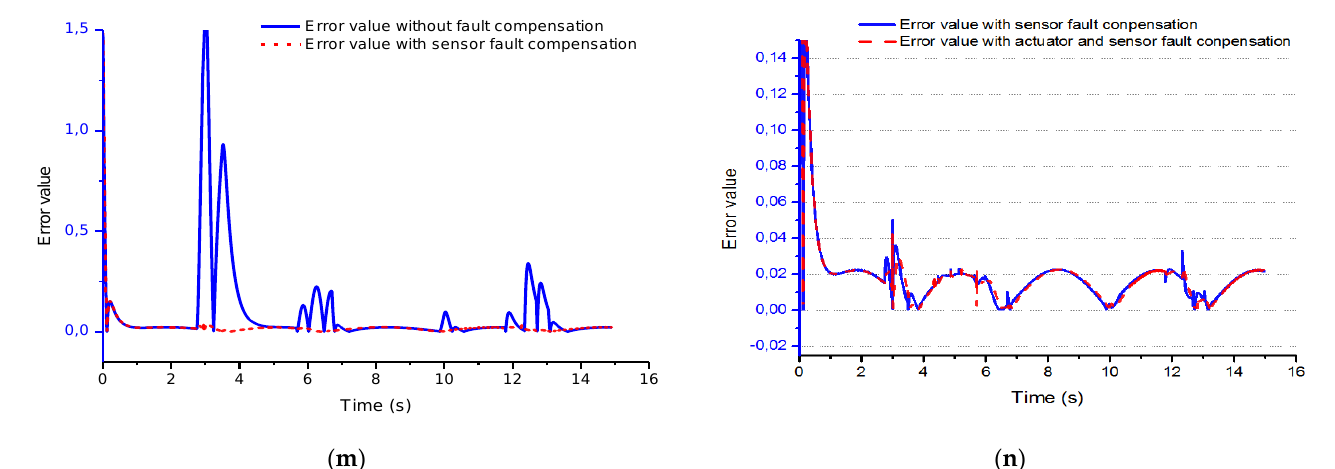
Figure 6. Simulation results of EHA system under the impact of the actuator fault, the position, and velocity sensor fault. ( a ) Position response for the case without compensation of ( f a , f P , f v ) faults. ( b ) Actuator fault estimation for the case without compensation of ( f a , f P , f v ) faults. ( c ) Position sensor fault estimation for the case without compensation of ( f a , f ) faults. ( d ) Velocity fault estimation for the case without compensation of ( f a , f ) faults. ( e ) Control error for the case without ( f a , f P , f v ) fault compensation. ( f ) Control error evaluation for the case without ( f a , f P , f v ) fault compensation. ( g ) Control error for the case with ( f P , f v ) fault compensation. ( h ) The obtained error evaluation for the case with ( f P , f v ) fault compensation. ( i ) Position response for the case ( f a , f P , f v ) fault compensation. ( j ) Actuator fault estimation for the case ( f a , f P , f v ) fault compensation. ( k ) Position fault estimation for the case ( f a , f P , f v ) fault compensation. ( l ) Velocity fault estimation for the case ( f a , f P , f v ) fault compensation. ( m ) The obtained error evaluation for the case without compensation of ( f a , f P , f v ) faults. ( n ) The obtained error evaluation for the case with compensation of ( f a , f P , f v ) faults.